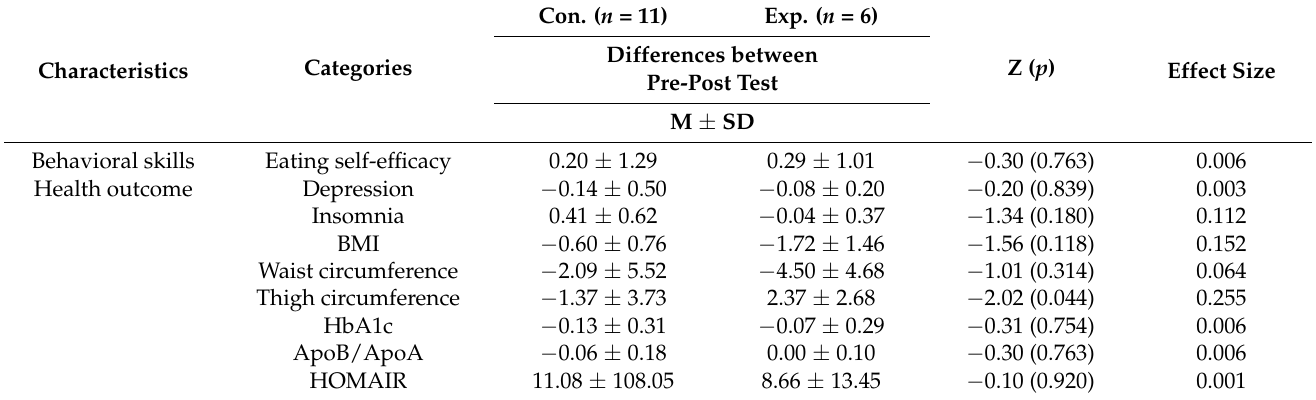
Table 2. Effects of non-contact dietary coaching program in the male participants ( n =